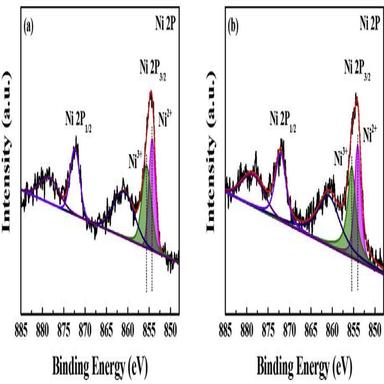
The Ni 2p XPS spectra of NCM622 (a) and Cu-NCM (b) samples.